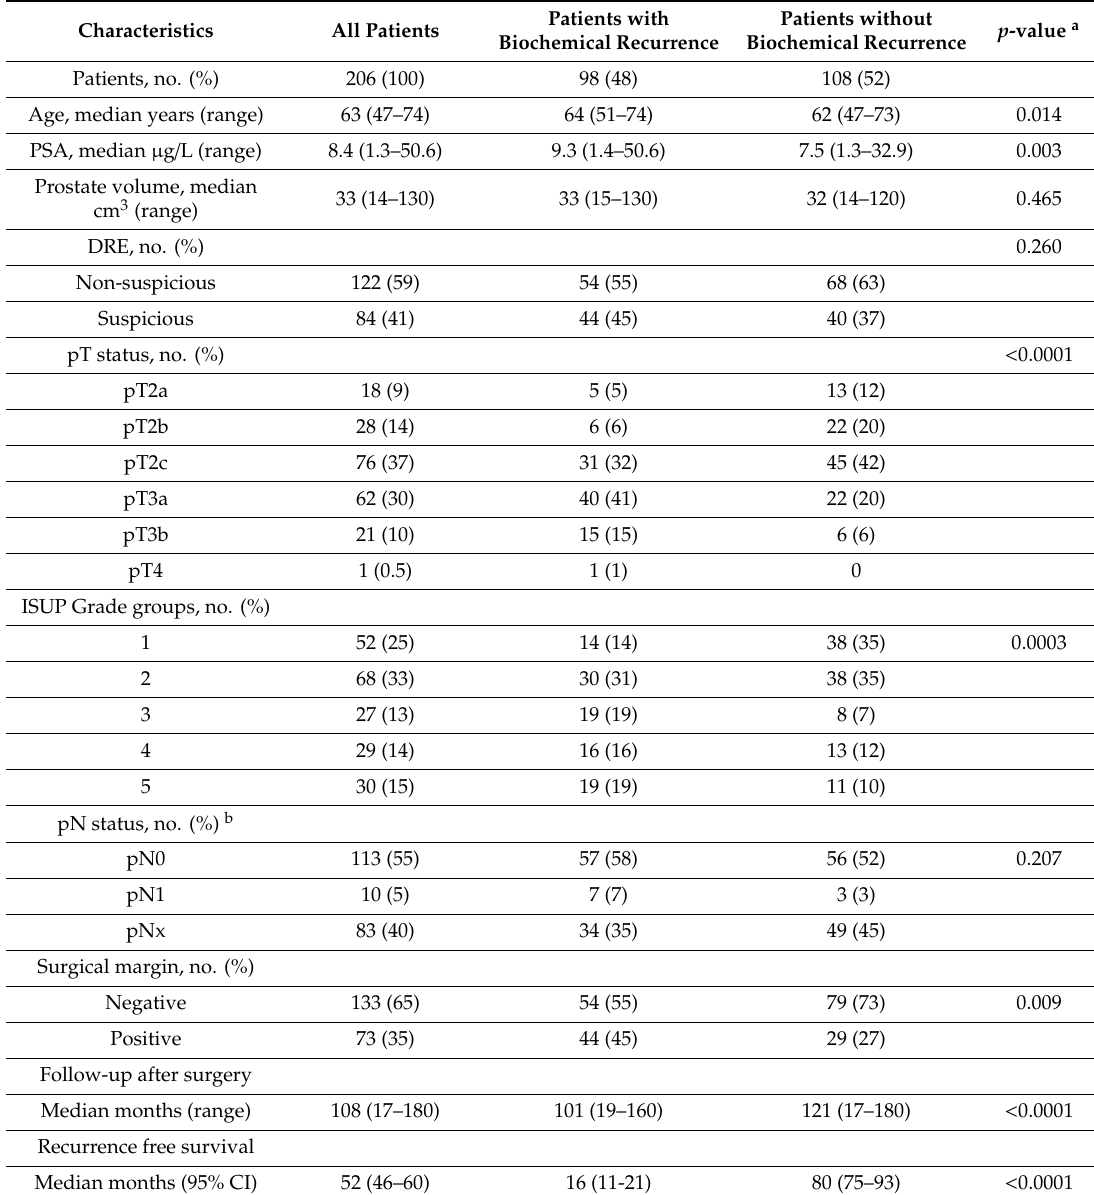
Table 1. Clinicopathological characteristics of the study